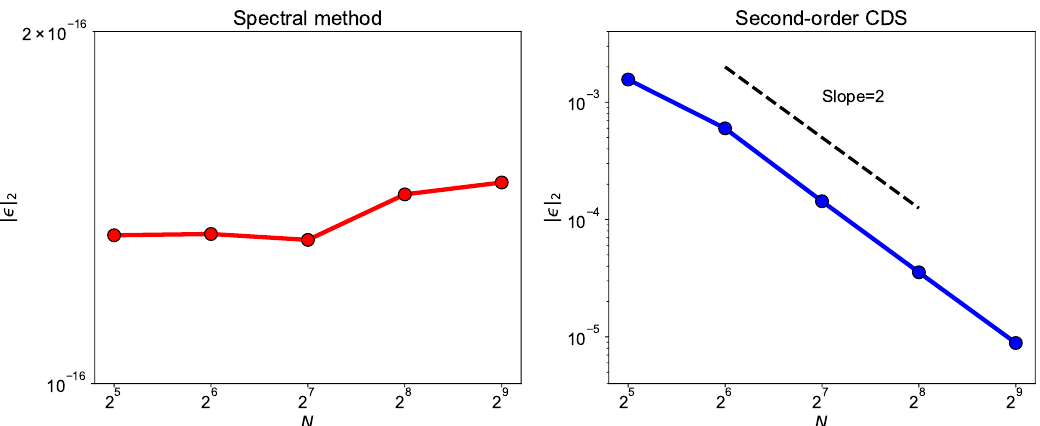
Figure 18. Order of accuracy for spectral method and second-order CDS. We calculate discretization error at five grid resolutions and change the grid size by a factor of 2 in both x and y direction. The CDS Poisson solver give second-order accuracy. Spectral method give exact solution and error is of the same order as machine